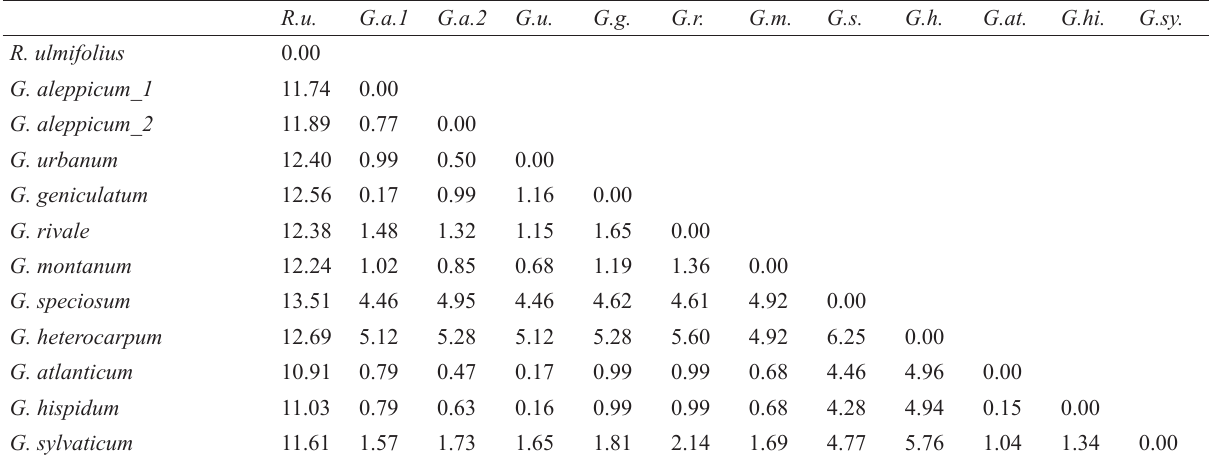
Table 3. Pairwise comparisons of sequence divergence (in percentages) of the entire ITS1-5.8S-ITS2 region among the species of Geum and Rubus ulmifolius . Identical sequences of Rubus ulmifolius , G. urbanum , G. atlanticum , G. hispidum and G. sylvaticum have been eliminated from the analysis.